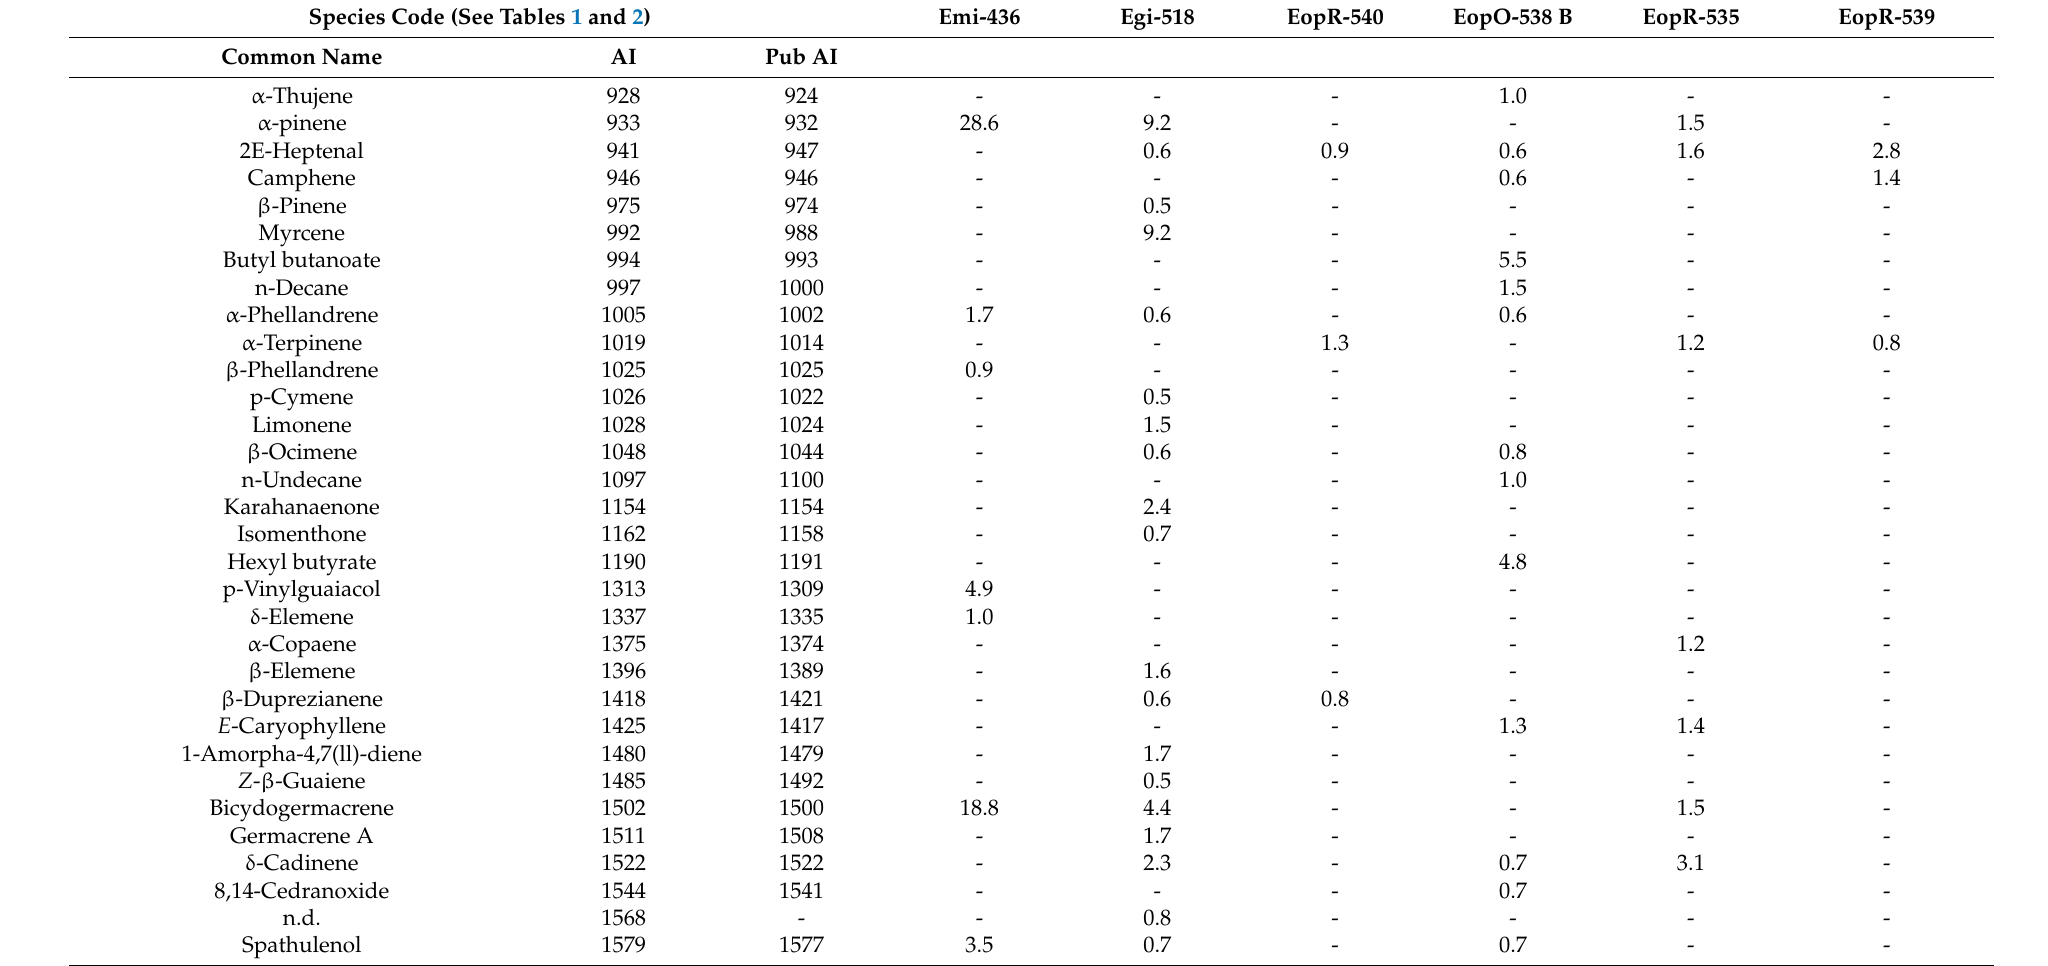
Table 12. Solvent extract volatiles from Eremophila mitchellii (Emi), E. gilesii (Egi), E. oppositifolia (Eop) subsp. rubra (EopR) and subsp. oppositifolia (EopR). Species Code (See Tables 1 and